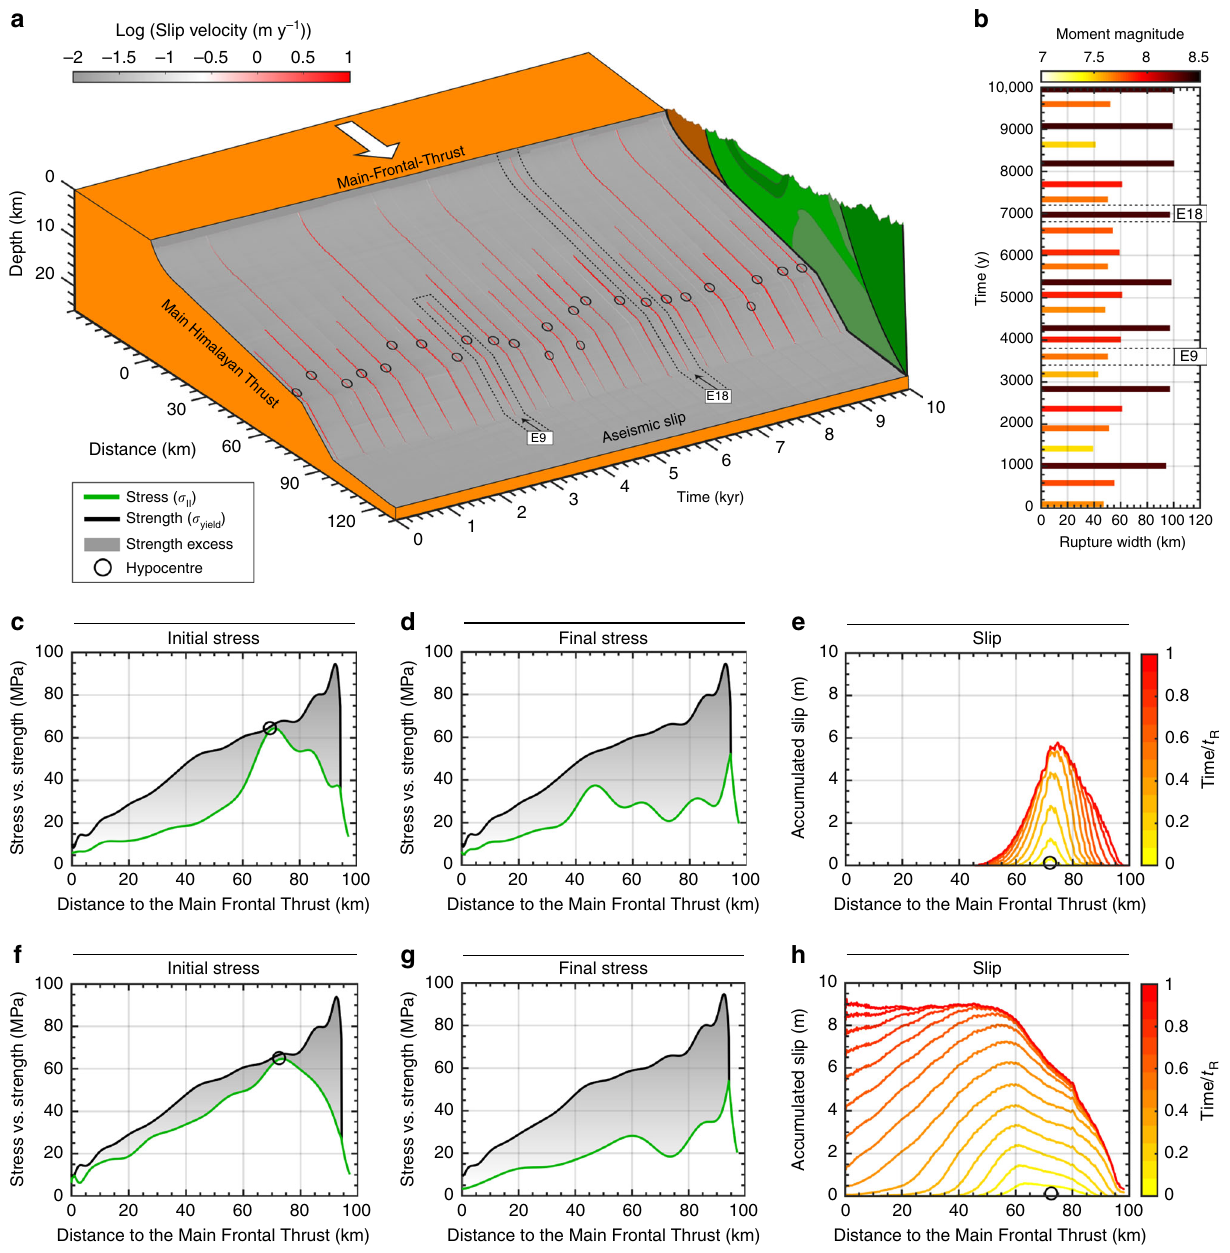
Fig. 3 Megathrust behaviour computed in the 2D model (EF) over 10,000 years. a , Spatiotemporal evolution of slip on the MHT for the reference model. Red lines show slip during the simulated earthquakes. Note that hypocenters (black circles) are typically located in the lower edge of the fl at segment, just before the mid-crustal ramp. b , Time evolution of downdip rupture width. Colorbar indicates the corresponding moment magnitude. c , d , Along megathrust pro fi les of initial ( c ) and fi nal ( d ) stress vs. strength for the partial rupture event E9. e , Contours of accumulated coseismic slip throughout event E9. f , g , Along megathrust pro fi les initial ( f ) and fi nal ( g ) stress vs. strength for the complete rupture event E18. h , Contours of accumulated coseismic